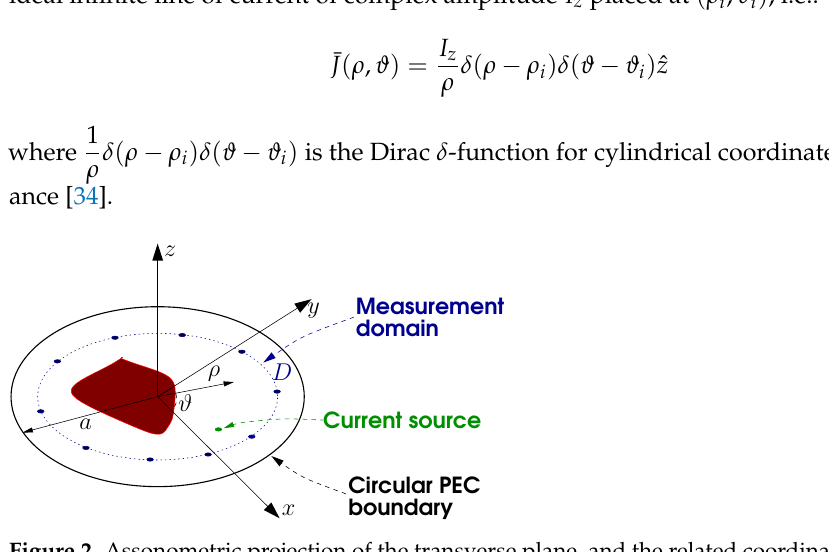
Figure 2. Assonometric projection of the transverse plane, and the related coordinate